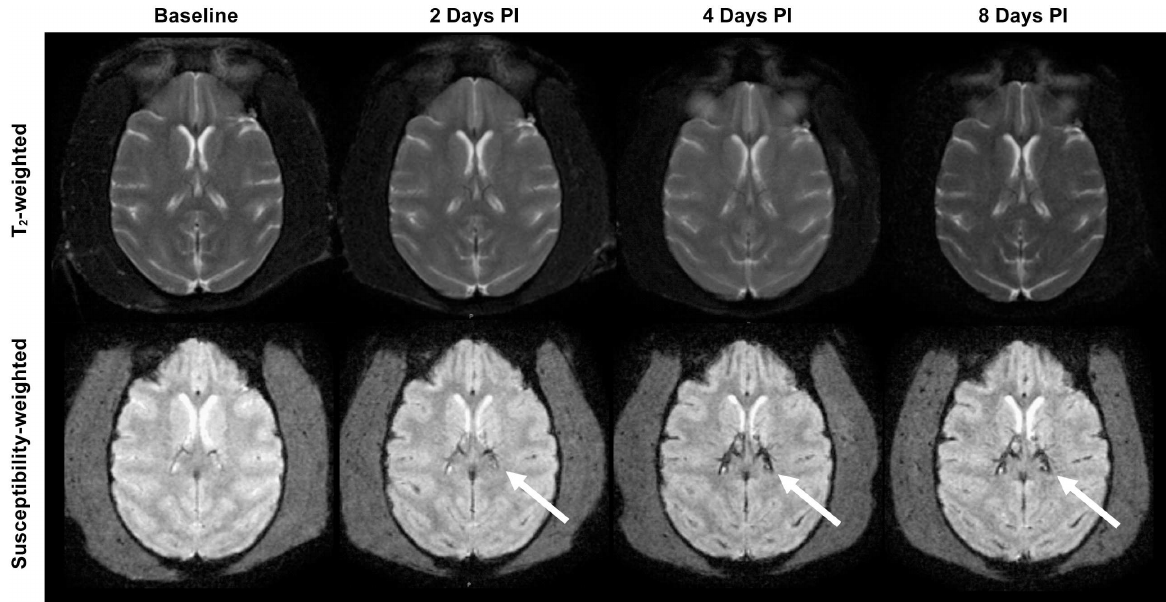
Fig 5. Images of an AGM that underwent MRI before and after aerosol infection with NiV. In this model, neither infection route led to abnormal signal intensity lesionsto suggest encephalitiswithin the brain parenchyma on T2 or on FLAIR weightedimages (T2 weightedimage, upper row). There was no evidenceof abnormal enhancement seen after contrast injection. However, in 2 of the 6 AGMs studied, susceptibility weightedimages showedincreasedvisibility/prominenceof the deep central and superficial venous structures (white arrows, lower row), comparedto baseline, as early as 2 days after infection. This could reflect increased deoxyhemoglobinconcentration within the vessels dues to vasodilationand venous stasis possiblypart of the systemic manifestations of Nipahvirus infection. No parenchymal hemorrhagicchanges were